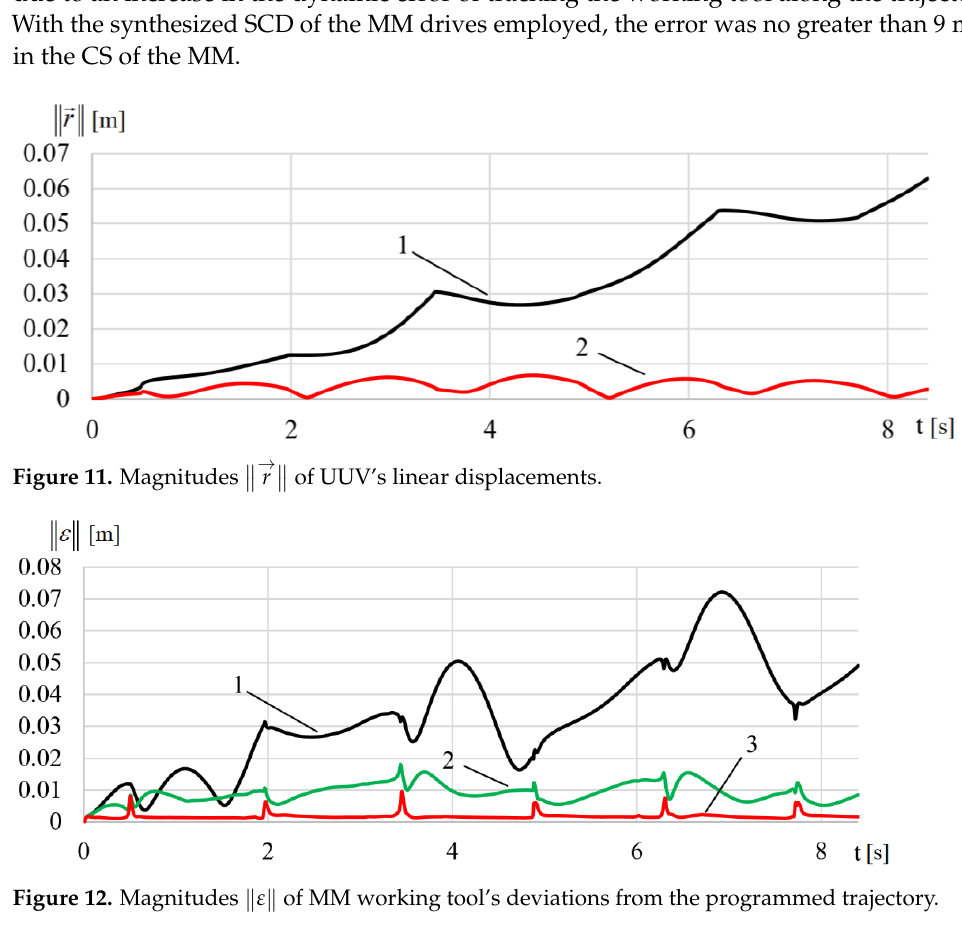
Figure 12. Magnitudes ‖𝜀‖ of MM working tool ’s deviations from the programmed trajectory.